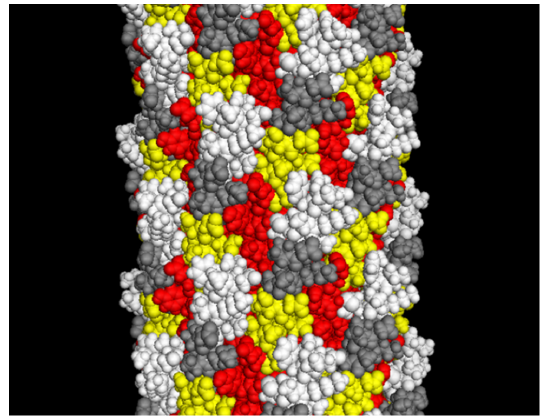
Figure 3. The landscape phage model (~10 nm segment of the full length). White: depicted atoms belong to the foreign peptides; yellow: pictured random amino acids in the phage α-library [28]; red: depicted amino acids belong to a small displayed segment of the hydrophobic domain predominantly buried in the capsid; grey: depicted amino acids belong to a “conservative” small segment of amphipathic domain. Adapted from [20].